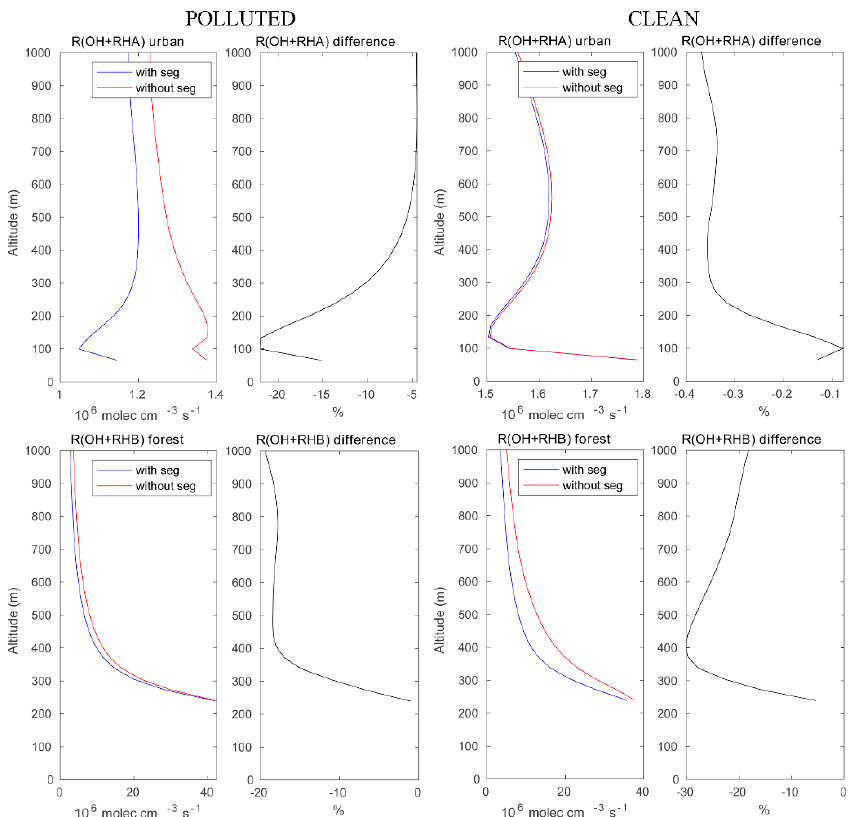
Figure 4. Upper panels: reaction rates of OH with RH-A in the urban area with and without segregation. Lower panels: same but for the reaction of OH and with RH-B in the forested area. Left panels: polluted conditions; right panels: clean condition. The relative difference between the cases with and without segregation is equivalent to the segregation intensity.